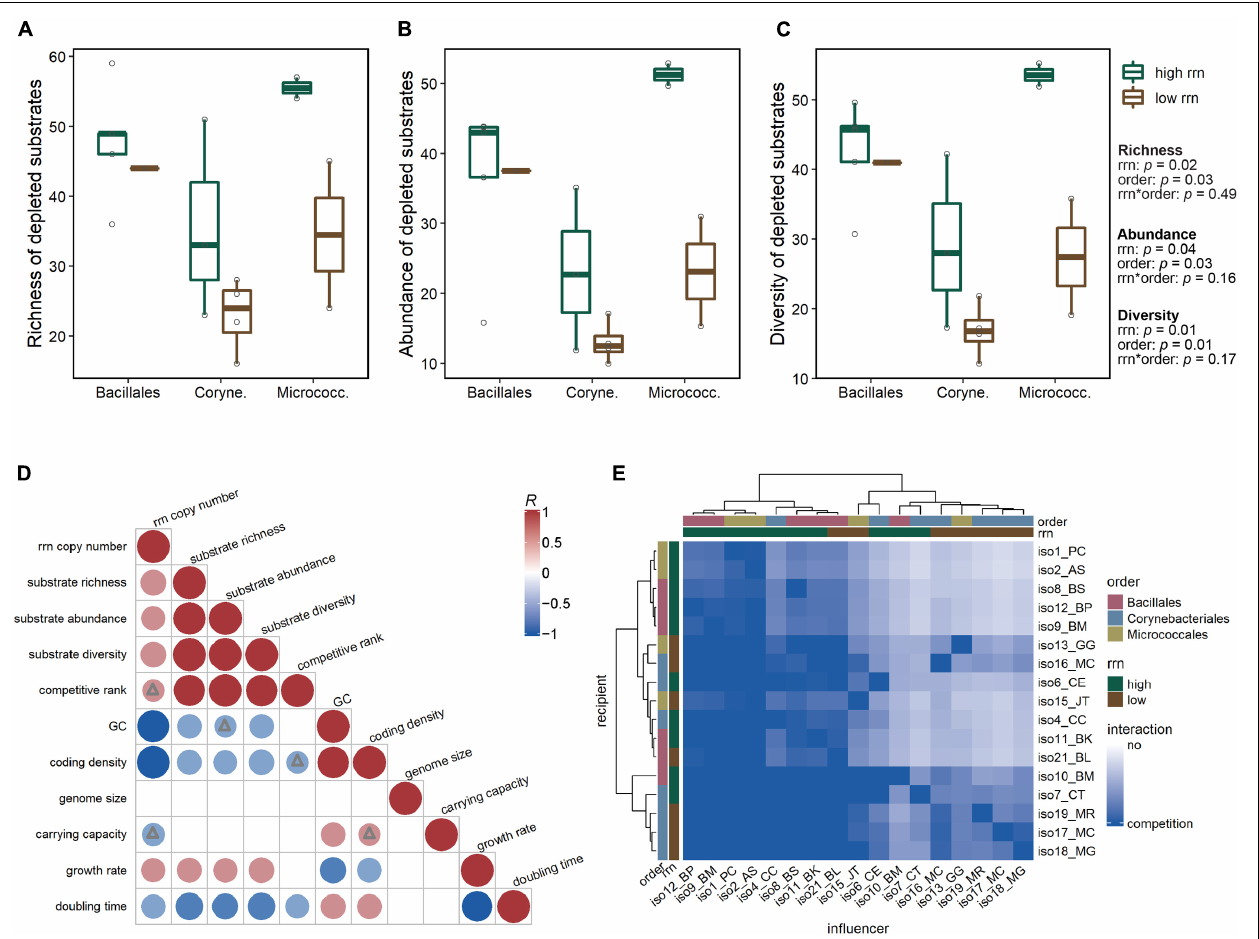
FIGURE 3 | Substrate utilization and competition potential. Differences in substrate utilization among taxonomic and rrn copy groups reflected by (A) the richness, (B) abundance, and (C) diversity of substrates used by each isolate. All three substrate utilization metrics were significantly affected by rrn copy group and taxonomic group (ANCOVA, p < 0.05). (D) Pearson correlation coefficients ( R ) between isolate substrate utilization metrics, predicted competitive ranking, genomic features, and estimated growth parameters. Positive correlations are displayed in red and negative correlations in blue. Color intensity and size of the circles are proportional to the correlation coefficients. Circles without triangles represent significance level p < 0.05; triangles represent 0.05 < p < 0.1. For insignificant correlations ( p > 0.1), the correlation coefficients are left blank. (E) Heatmap of directional pairwise competitive interaction strengths, predicted based on overlap in substrate utilization profiles. In heatmap color bar, label “no” represents no overlap in substrate use profiles, predicting no competition between isolates; darker blue color represents higher similarity in substrate use, predicting a higher potential that the influencer will compete with the recipient for